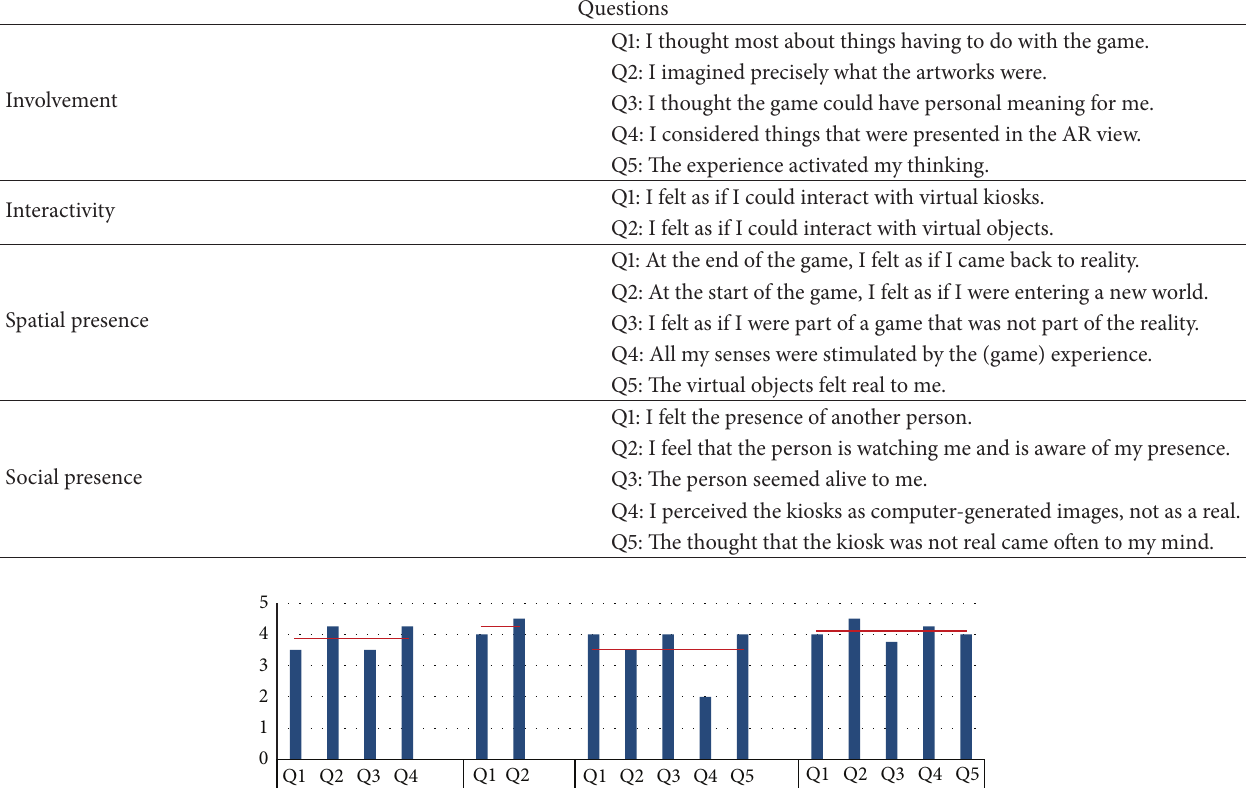
Table 1: The statements used in the questionnaire to evaluate the sense of presence.